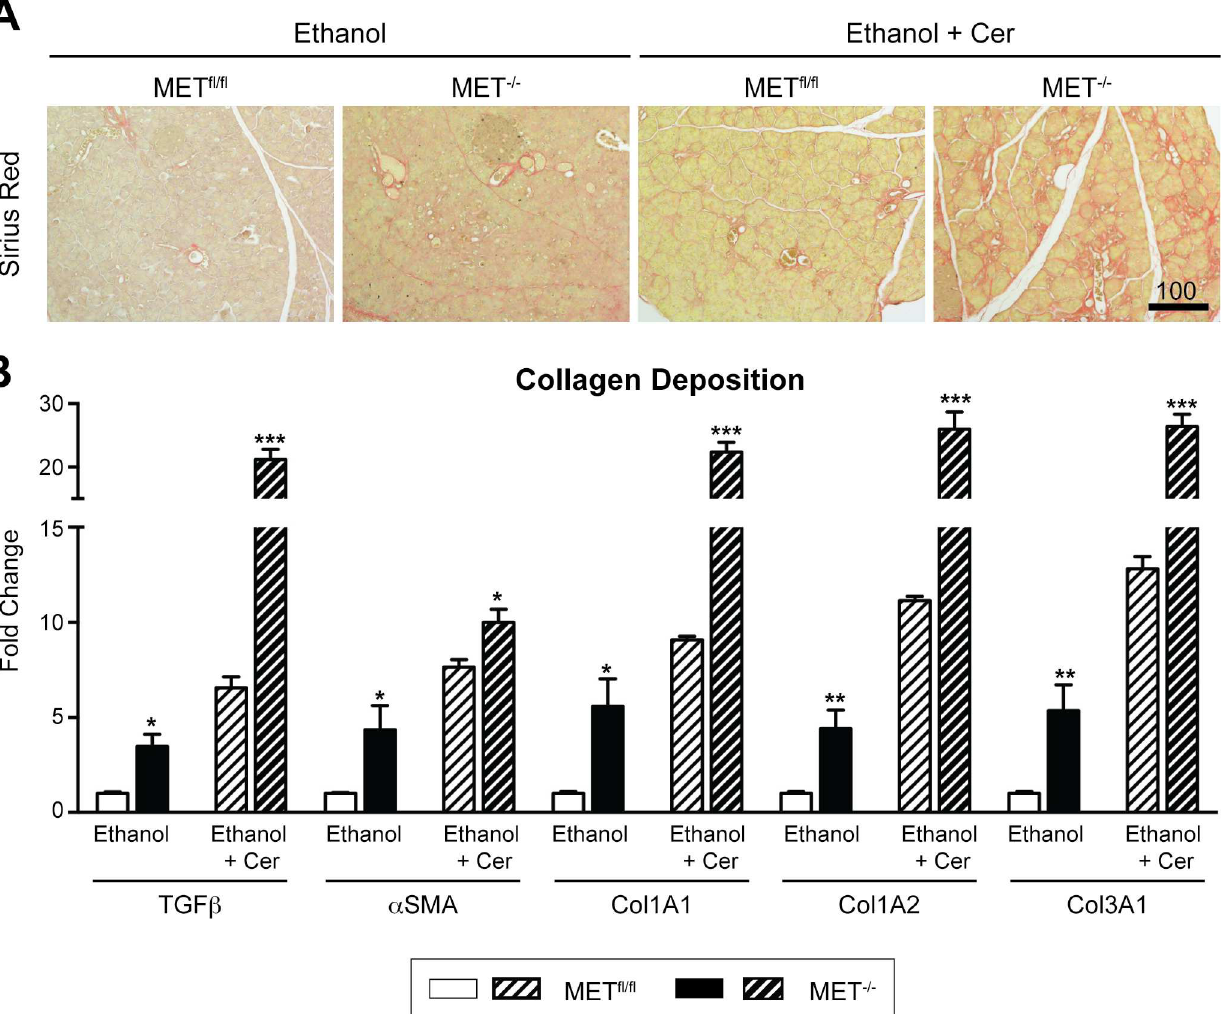
Fig 7. MET deletion caused increased collagen deposition. A, Sirius Red staining confirmed increasedcollagendepositionin MET -/- relative to MET fl/fl mice fed alcohol ± recurrent cerulein (Cer) induced injury are shown (Scale, microns). B, qRT-PCR confirmed relative changes in transcript levels in alcohol fed MET -/- ± cerulein (Cer) mice for mediators of pancreaticstellate cell activation and collagendeposition ( α SMA, TGF β , COL1A1, COL1A2 and COL3A1) (multiple t-test, * , p < 0.05; ** , p < 0.01; *** , p <